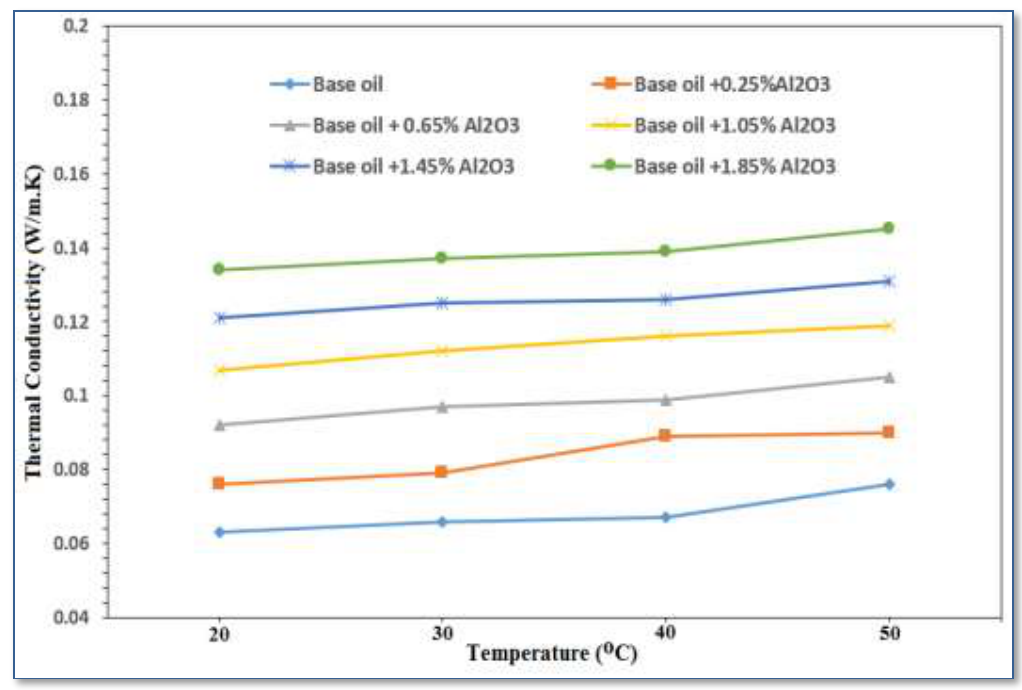
Figure 7: The influence of operating temperature and Al 2 O 3 NPs additions on the thermal conductivity value of nano-lube